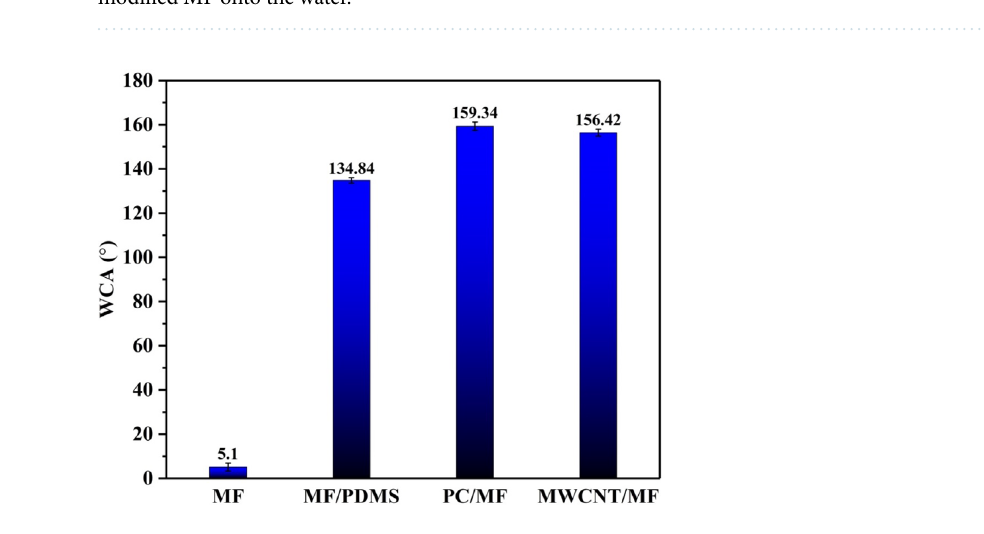
Figure 7. WCA variation of the liquid droplets on the pristine and modified